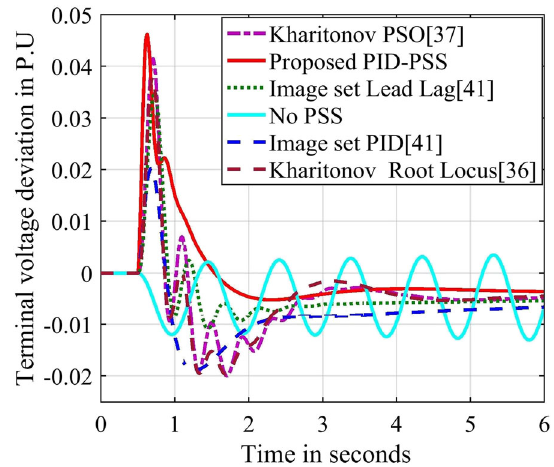
Fig. 18 Comparision of terminal voltage deviation response of the proposed with existing methods to 0.1p.u. torque disturbance at P = 1.2 p.u. and Q = 0.2p.u